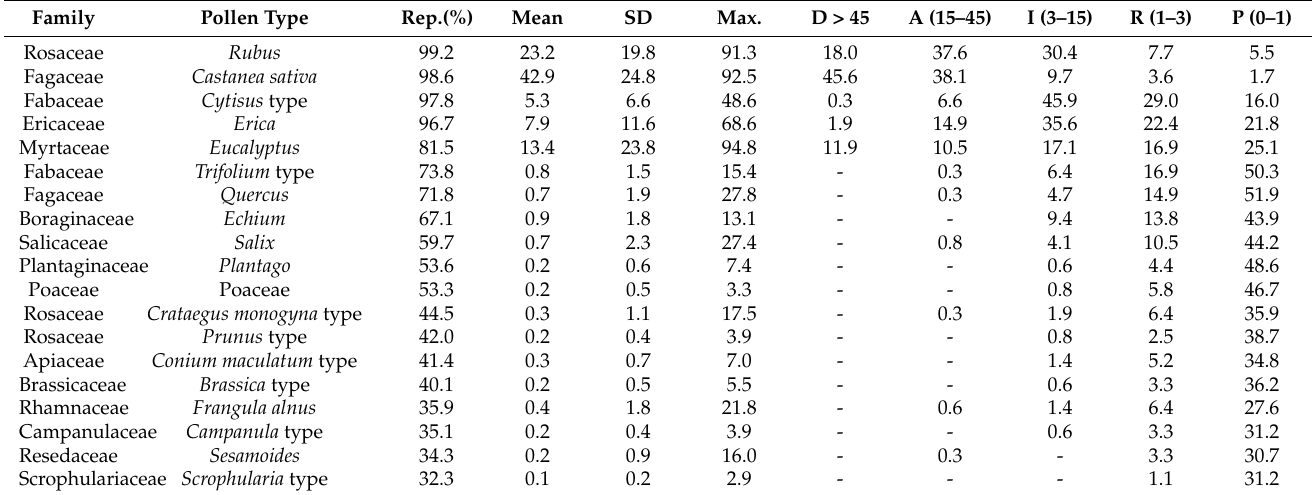
Table 1. Descriptive analysis of the families and pollen types found in more than 30% of